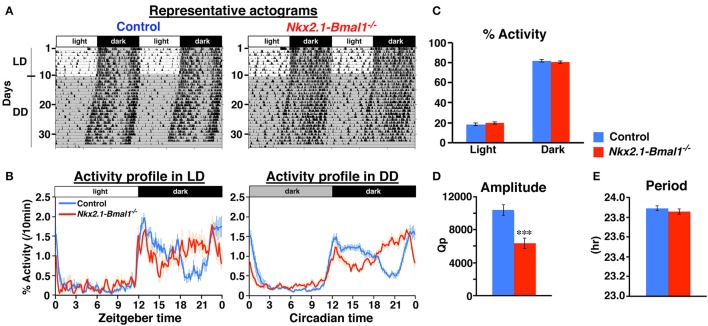
Temporal pattern of nocturnal locomotor activity is altered in Nkx2.1-Bmal1−/−. (A) Representative locomotor activity of control and Nkx2.1-Bmal1−/− mice. Animals were initially housed in 12:12-h light/dark (LD) conditions and later transferred to constant darkness (DD). Gray shading indicates when lights were off. (B) Daily profile of locomotor activity in LD or DD. Activity counts are expressed as percentage of daily total. (C) Relative activity during 12-h light phase (Light) and 12-h dark phase (Dark). No significant difference was detected between genotypes. (D,E) Mean free-running period and amplitude (Qp values of periodogram) in DD. Values for activity in DD were calculated for data on Days 5–19 in DD. Values are mean ± SEM. n = 14 for control, n = 11 for Nkx2.1-Bmal1−/− mice. ***p < 0.001 by a two-tailed Student's t-test.